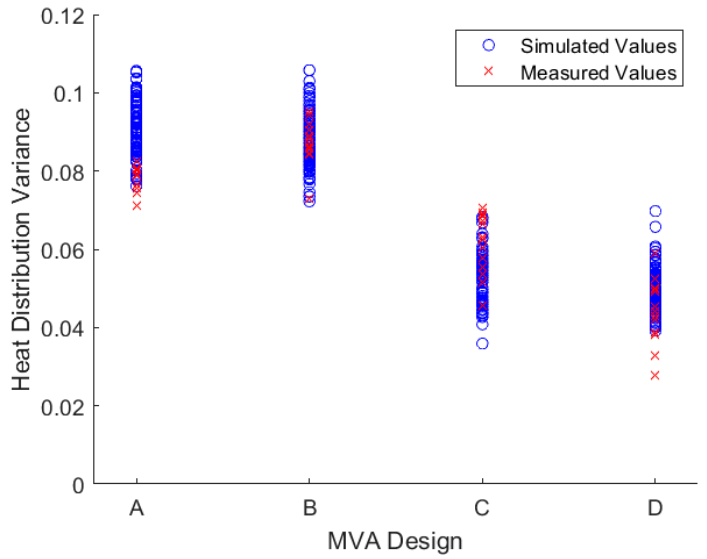
Figure 10. A comparison between the simulated and measured heat distribution for each design of MVA.